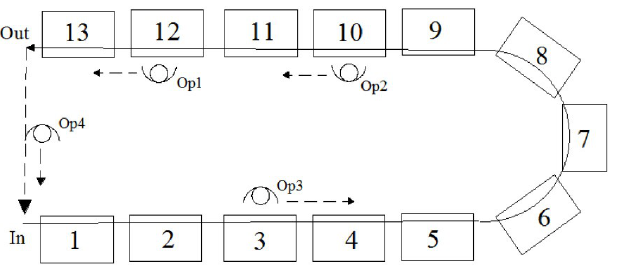
Figure 3. Rabbit Chase